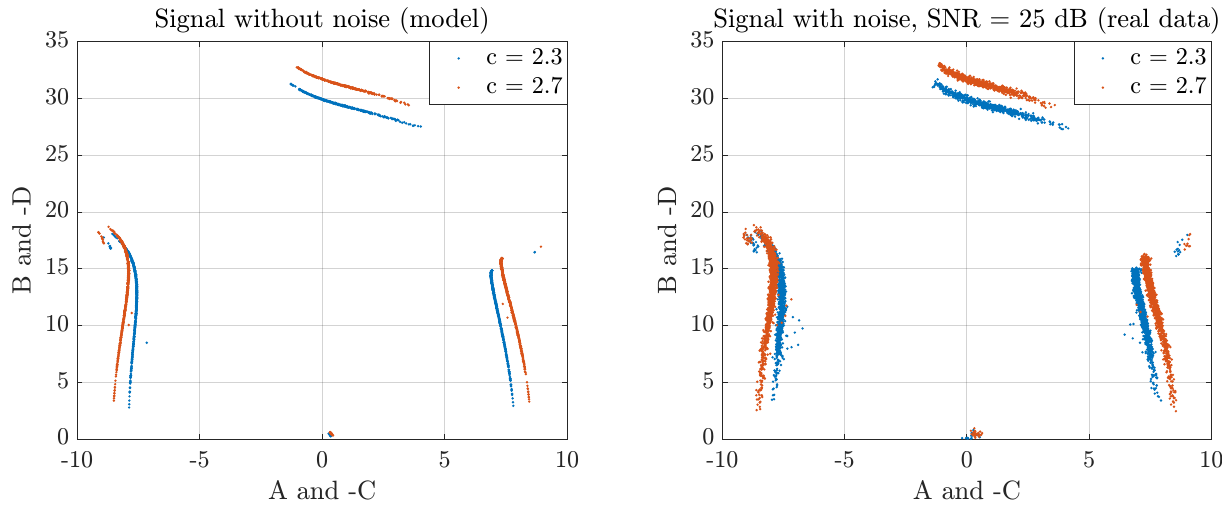
Figure 9. Return maps of the chaotic signal modulated with PM